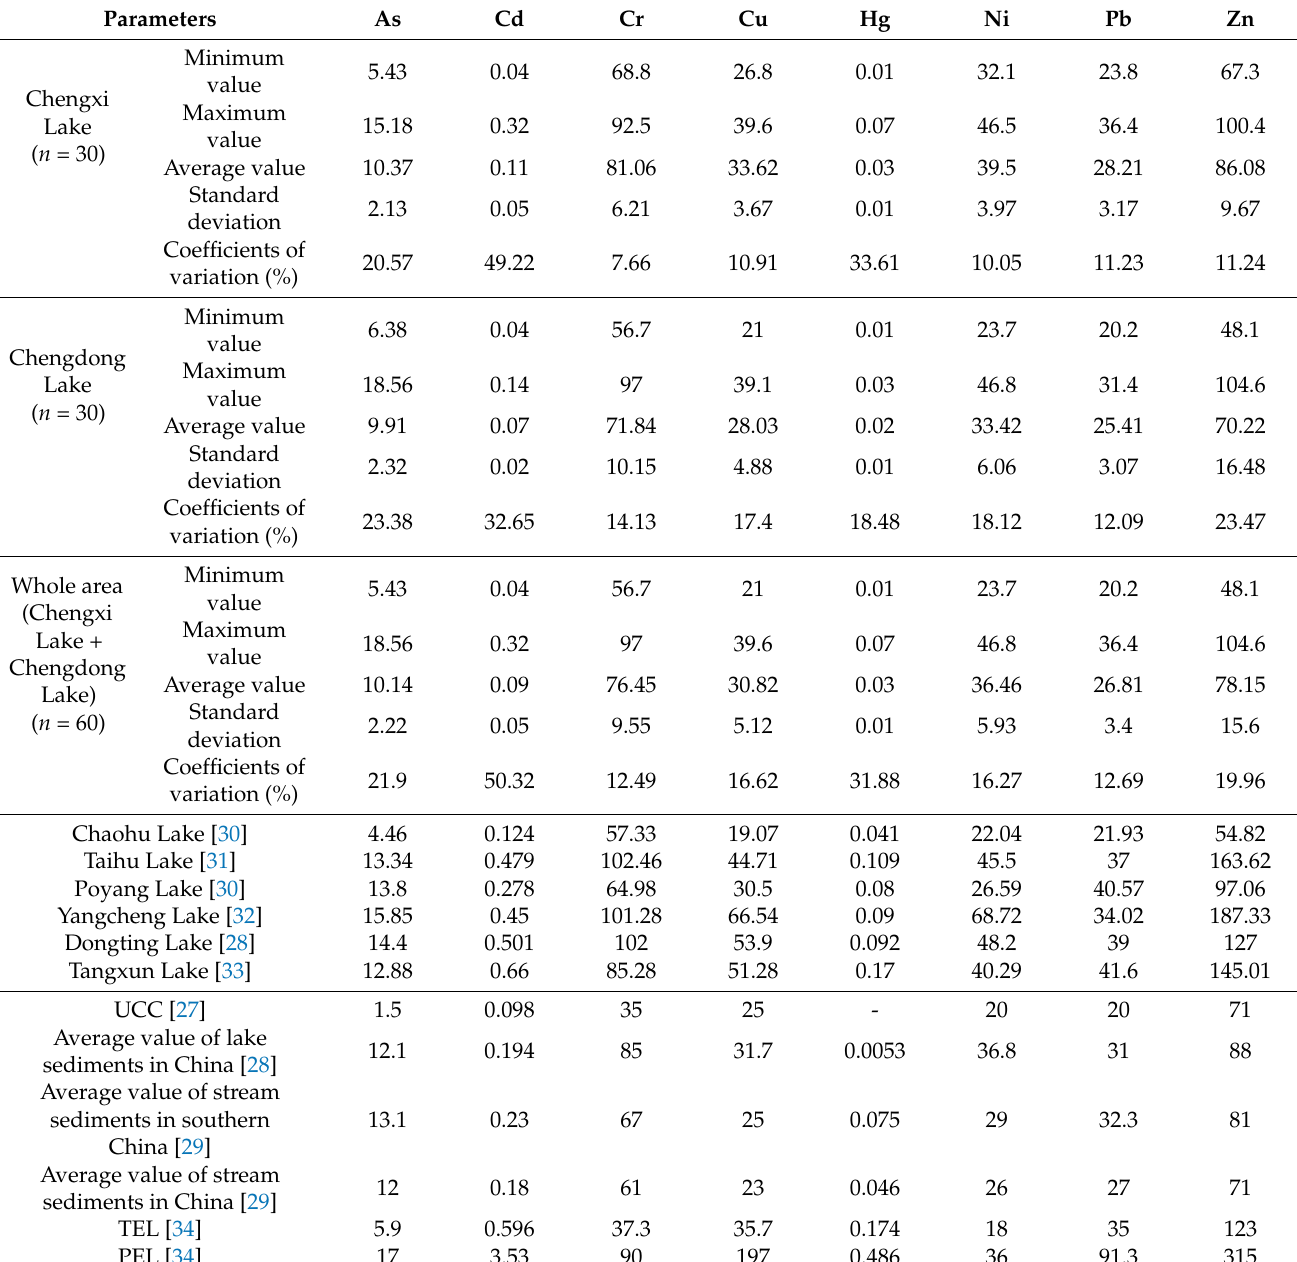
Table 2. Descriptive statistics of heavy metals in the sediments of lakes in study area (mg · kg − 1